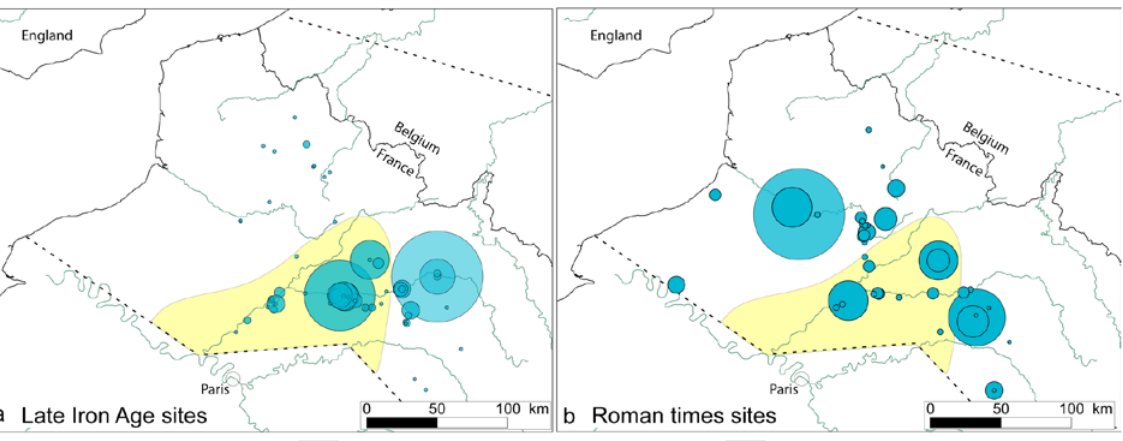
Figure 9. Lutetian limestone rotary querns from the north of France. Distribution of rotary querns beyond the extension of the limestone